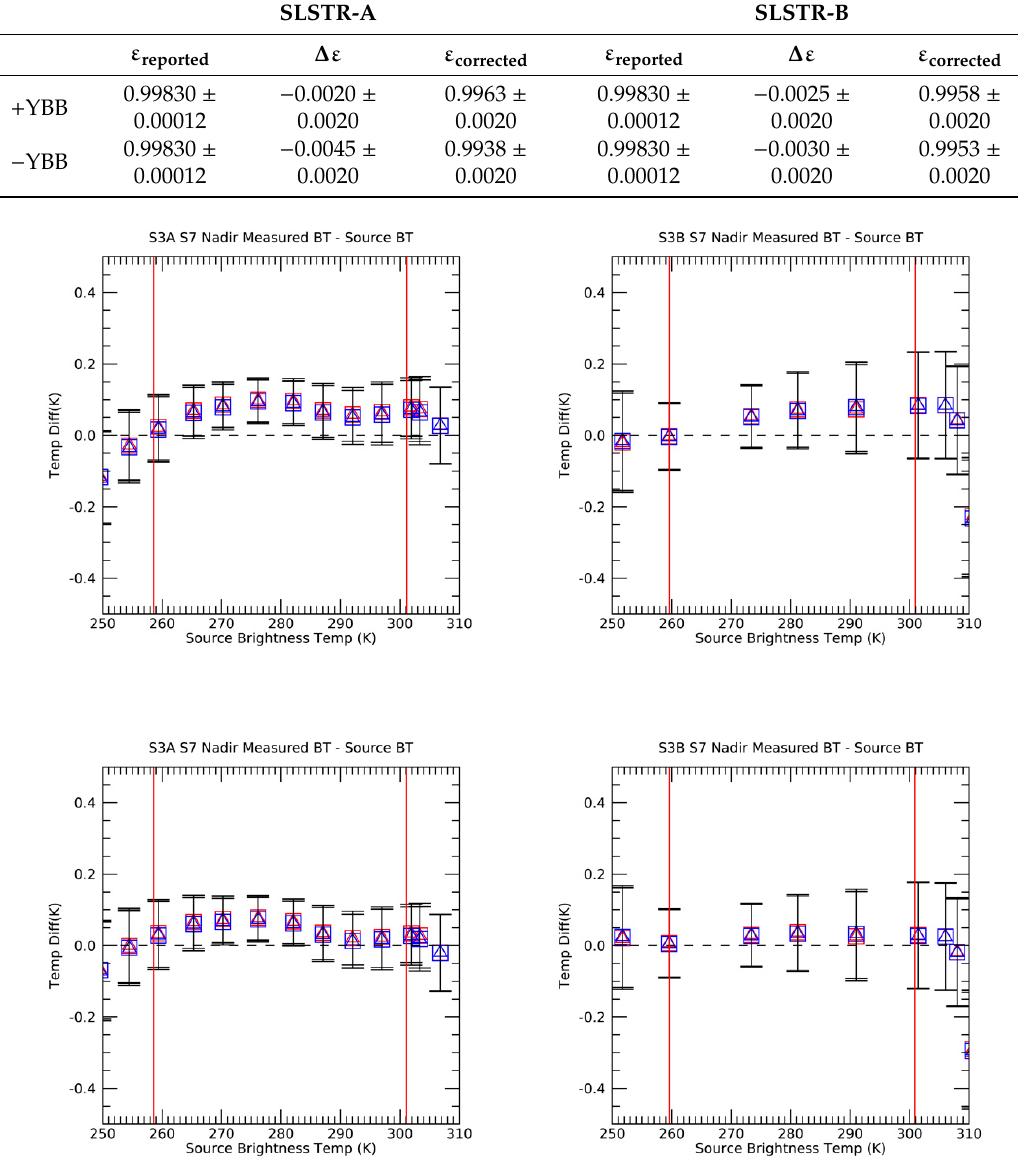
Figure 16. S7 BT di ff erences before (top) and after adjusting (bottom) the instrument BB emissivity to the corrected values in Table 9. ☐ = Detector 1, Integrator 1; ☐ = Detector 1, Integrator 2; Δ = Detector 2, Integrator 1; Δ = Detector 2, Integrator 2. Error bars represent the combined uncertainty at k = 3.